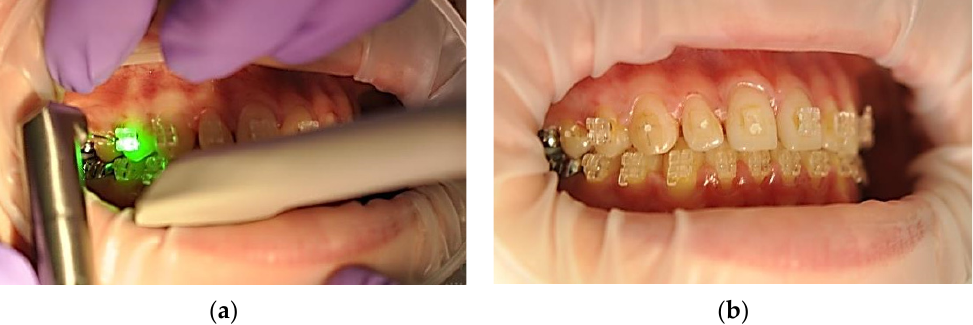
Figure 6. Application of laser Er:YAG radiation to dental units 1.3–1.1 ( a ) and clinical aspect after debonding ( b ).